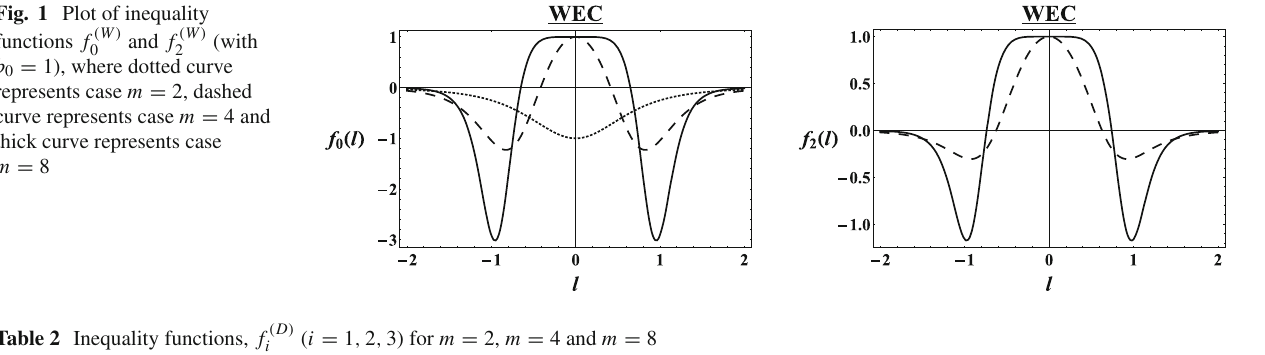
Table 2 Inequality functions, f ( D ) Function